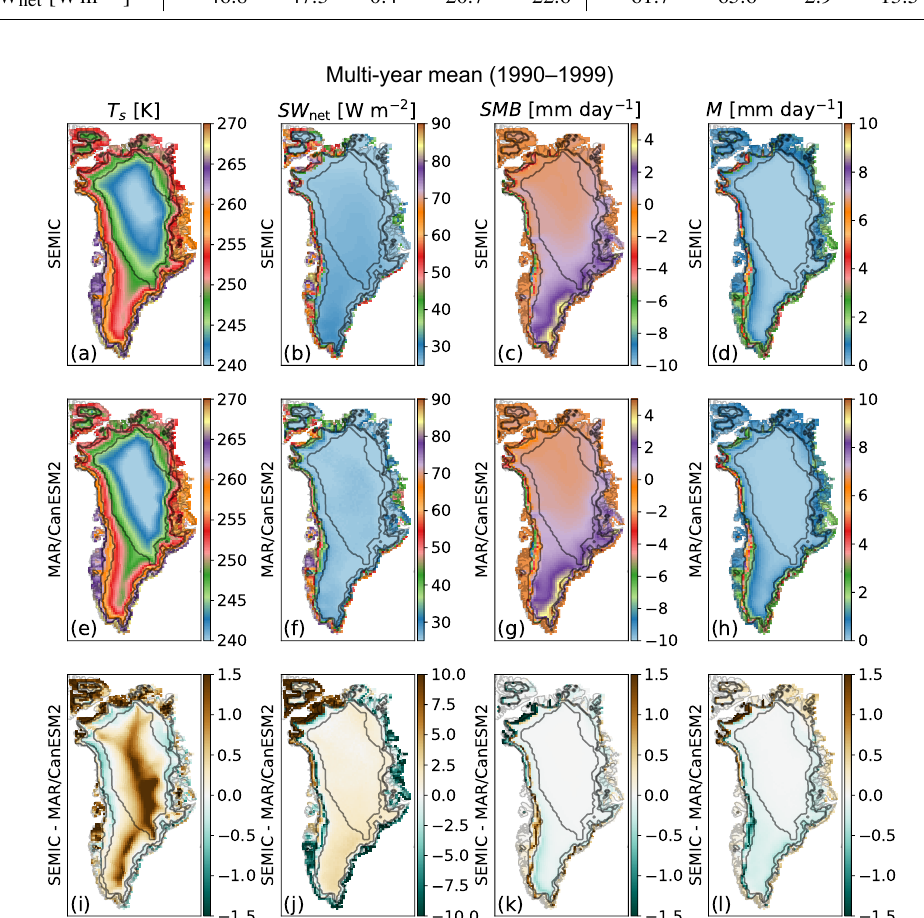
Figure 3. Comparison of multi-year (1990–1999) mean surface temperature T s , net shortwave radiation SW net , surface mass balance SMB, and surface melt M as modelled by SEMIC (a–d) and MAR (e–h) and the differences between SEMIC and MAR (i–l) . The outlined contours show the boundaries of the three ice-covered MAR regions as shown in Fig. 2. See Table 4 for values of minimum and maximum differences.